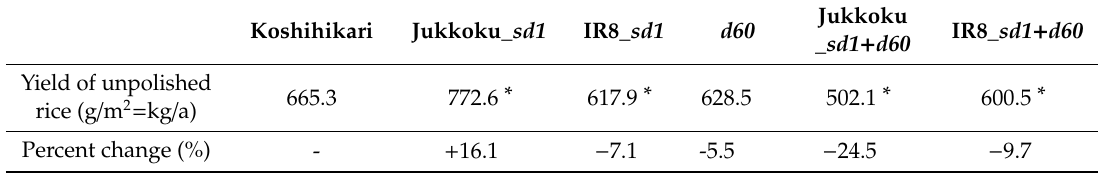
Figure 7. Yield of semidwarf and double dwarf gene lines. The yield of unpolished rice was 665.3 g / m 2 in Koshihikari, 772.6 g / m 2 in line carrying Jukkoku_ sd1 ( + 15.9% vs Koshihikari), 617.9 g / m 2 in line carrying Kinuhikari _sd1 ( − 7.1% vs Koshihikari), and 628.5 g/m 2 in line carrying d60 ( − 5.5% vs Koshihikari). Table 6. Effect of semidwarf and double dwarf genes to yield.